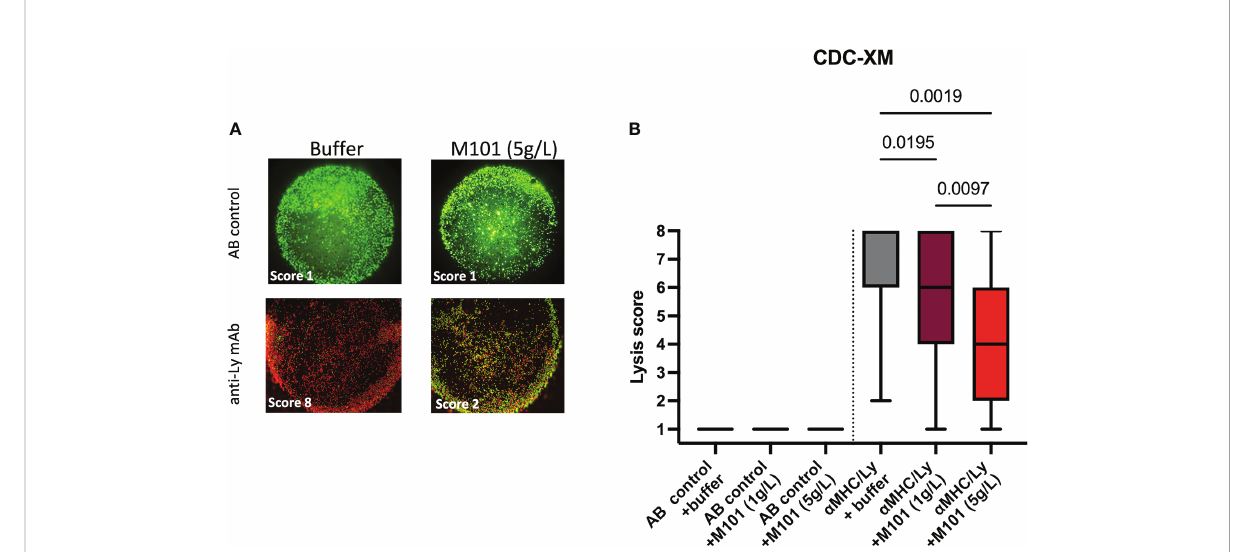
FIGURE 2 M101 inhibits complement-dependent cytotoxicity crossmatch (CDC-XM) positivity. Sorted B- and T-cells were incubated with a negative AB control serum or a positive control serum (see Table 1 for details), and next with rabbit complement containing various concentrations of M101 (buffer, 1 g/L, or 5 g/L). Assessment between live (colored in green) and dead cells (colored in red) was achieved by fl uorescent microscopy, and a lysis score was established (see material and methods). (A) A representative result of T cells incubated with a negative AB control (upstream) or with an anti-lymphocyte (Ly) monoclonal antibody (mAb) used as positive control in the CDC-XM assay (downstream) in the presence of the buffer (left) or M101 at 5 g/L (right). (B) Results of 8 independent experiments and results are expressed as box plots of interquartile range. P values are indicated when signi fi cant (ANOVA